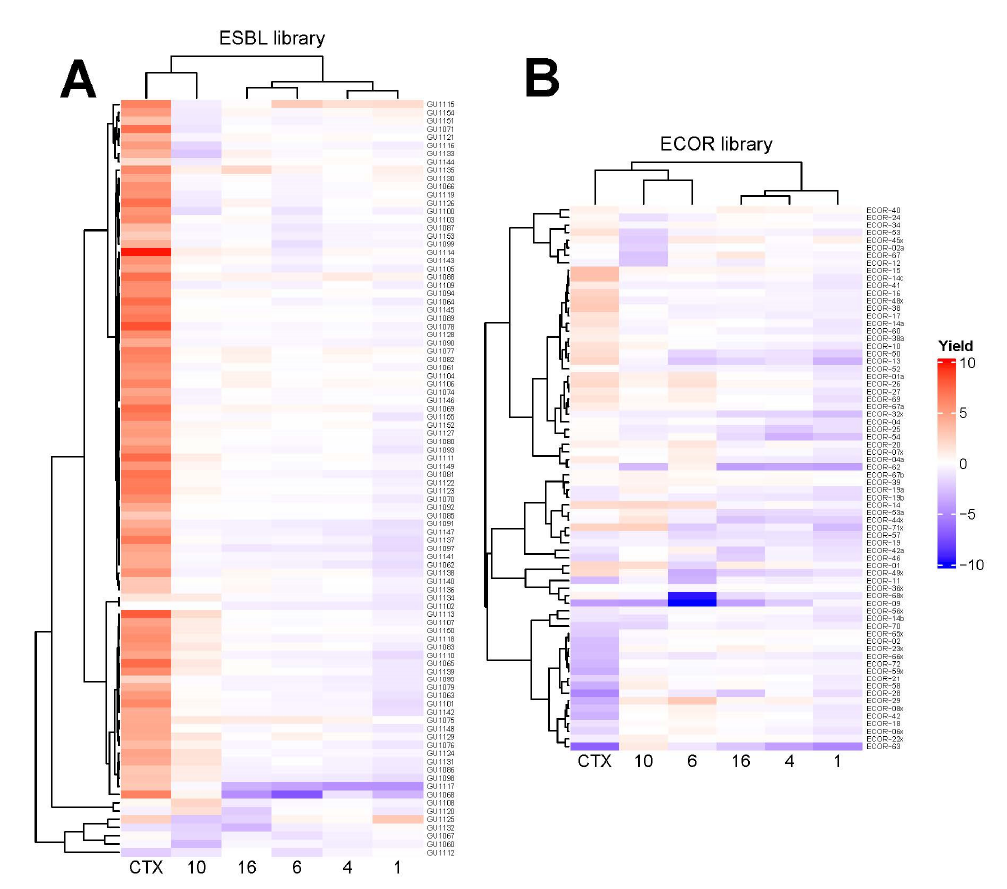
Figure 4. High-resolution microbial phenomics profiling of synthesized compounds 1 , 4 , 6 , 10 , 16, and known antibiotic CTX against two E. coli libraries (ECOR and ESBL). Heatmap clustering of the growth yield upon exposure to the compounds relative to our reference strain ( E. coli CCUG #17620/ATCC #25922) normalized for growth without added compound for the 92 strains of the ESBL library ( A ) and for the 72 strains of the ECOR library ( B ), using complete linkage hierarchical clustering method and Pearson’s distance measure method for computing distance between rows and columns. The values are expressed on a log(2) scale where positive and negative values indicate better (i.e., more resistant) and worse (i.e., more sensitive) yield compared to the control. The clustering and construction of the heatmaps was performed using the R package ComplexHeatmap v. 2.8.0 [27] .